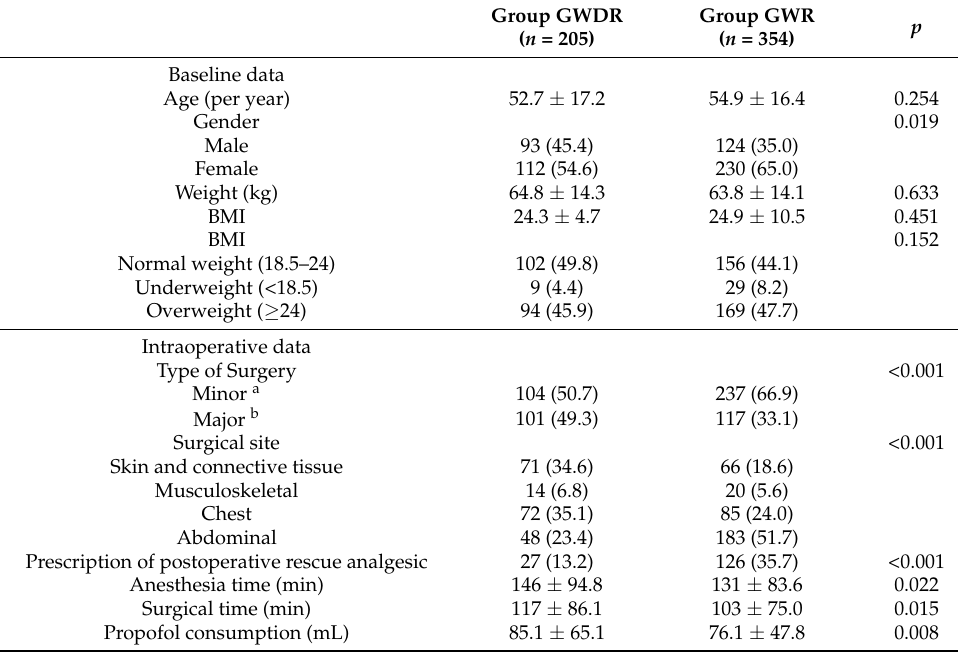
Table 1. Demographic